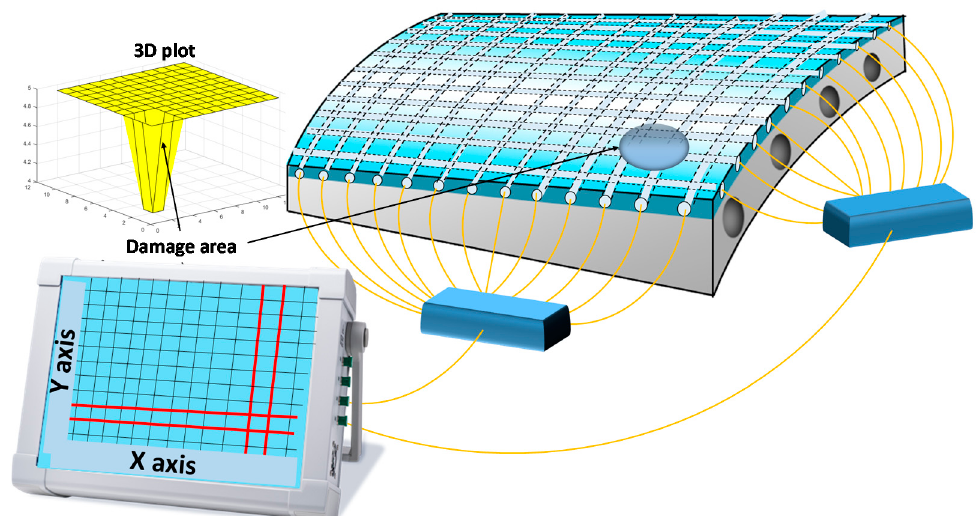
Figure 1. Final architecture of the 2D sol–gel matrix sensor for damage detection. The sensor is based on a grid of optical waveguides. An impact on the plane leads to the degradation or the rupture of one or more waveguides. Thanks to the particular 2D structure of the sensing material, the identification of the impacted damage allows the damage localization.